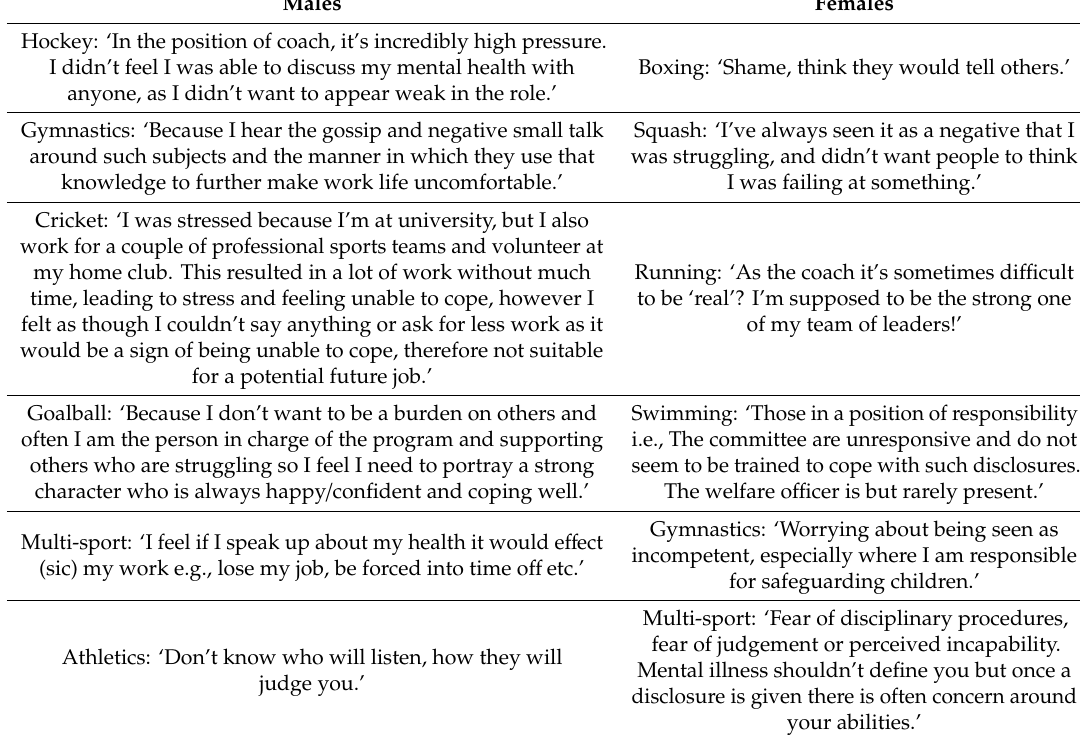
Table 7. Why coaches did not speak to others about their mental health, despite wanting to. Males